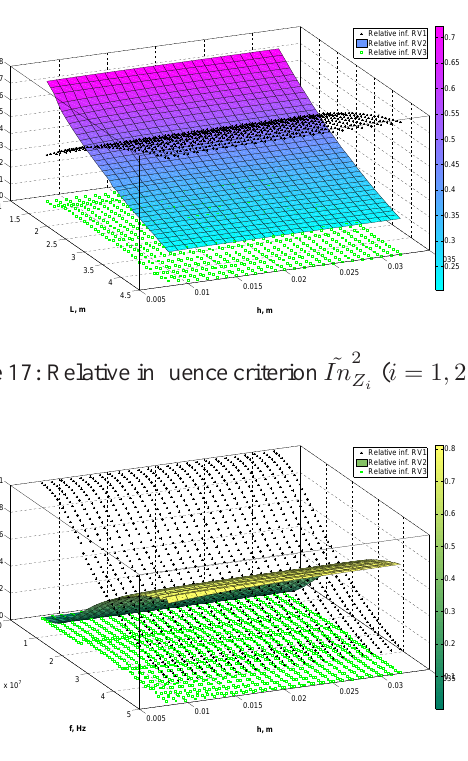
Figure 18: Relative influence criterion ˜ In